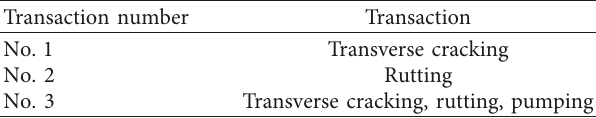
Table 3: Transaction database of distress types: an